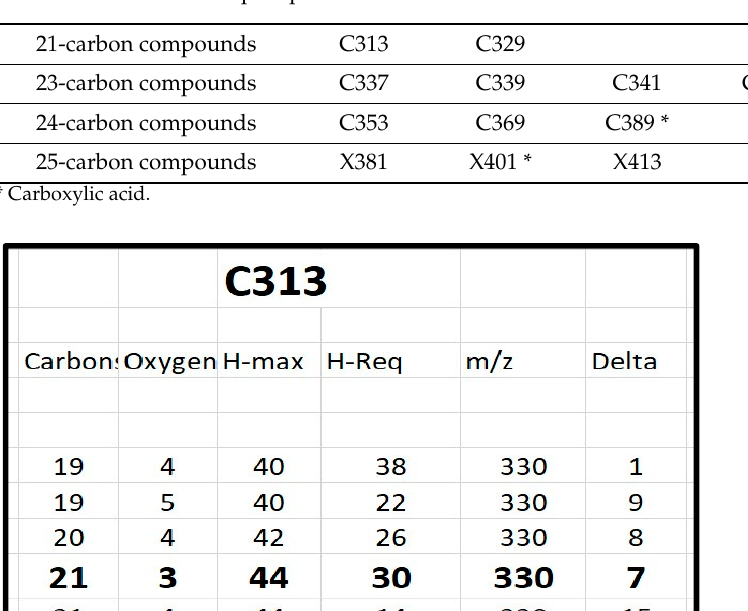
Table A1. List of steroid phosphodiesters identified.